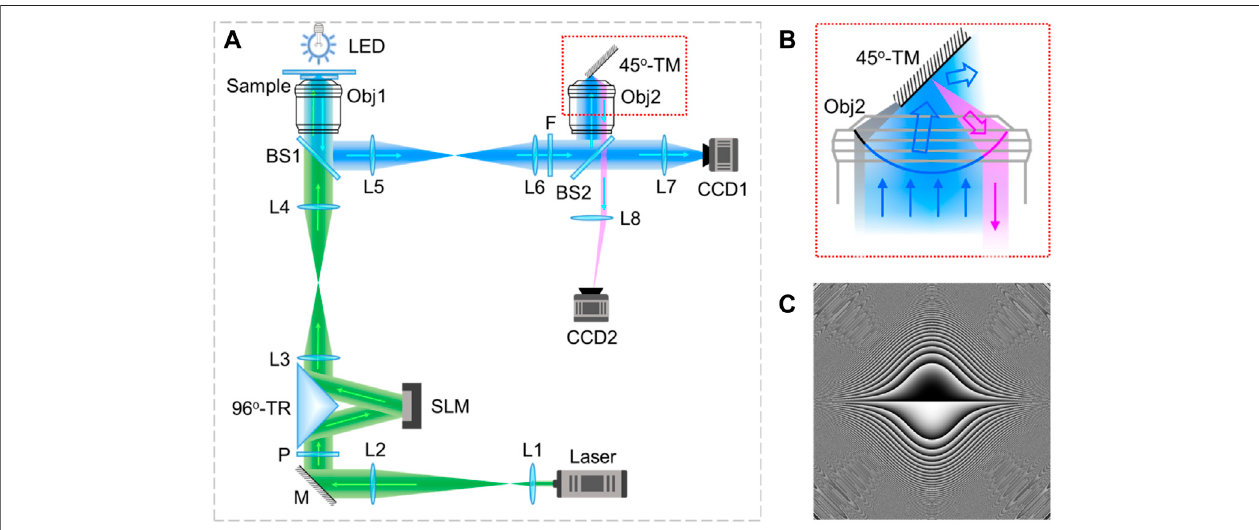
FIGURE1| Schematic diagram oftheWeber beamoptical tweezer system equipped withAPOM. (A) Opticalsetup; (B) enlargedviewofthe areamarked withred dotted rectangle in (A) ; (C) phase mask loaded on the SLM. L: lens, M: mirror, P: polarizer, 96 ° -TR: 96 ° -triangle re fl ector, BS: beam splitter, Obj: objective, LED: light emitting diode, F: fi lter, CCD: Charge coupled device, 45 ° -TM: 45 ° -tilted mirror.